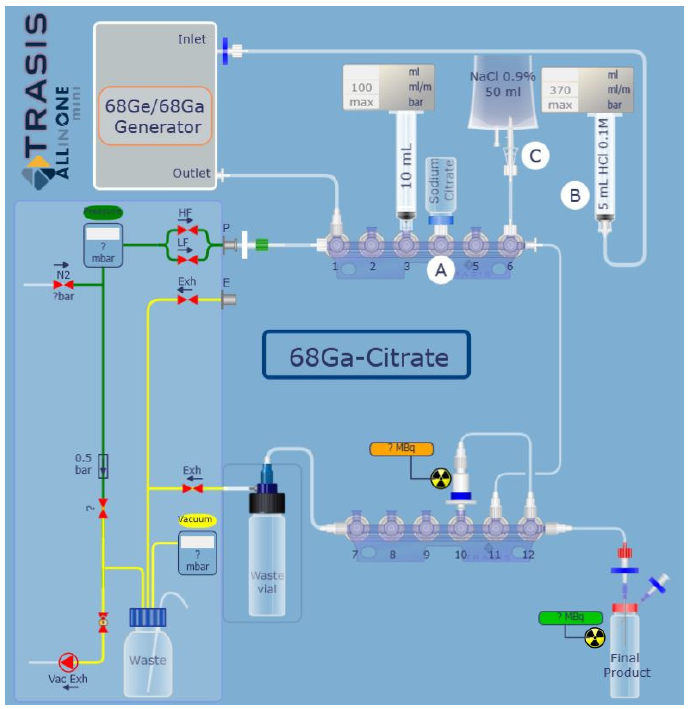
Figure 2. Graphical representation of radiosynthesis of [ 68 Ga]Ga-citrate on mAIO ® module.